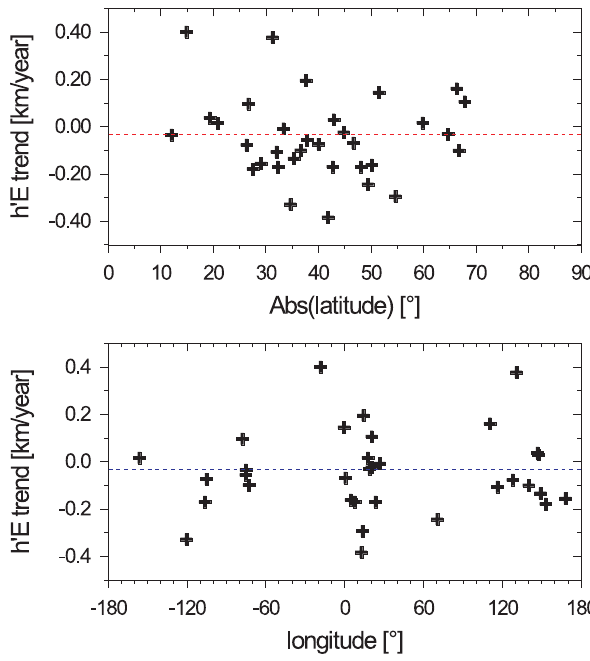
Fig. 6. foE trends in dependence on the absolute value of the lati- tude of the individual stations (upper part) and on the longitude of these stations (lower part). The dashed lines characterize the mean global foE trend, the full lines are the curves of the best linear fit (upper part) and sinusoidal fit (lower part) through the individual trend values.